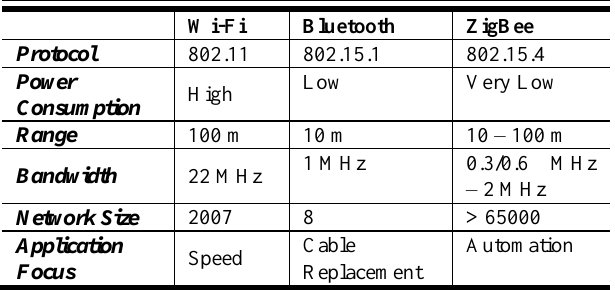
Table 1.1. Comparison of active RSSI based technologies (Proskochylo, A. et al., 2015).